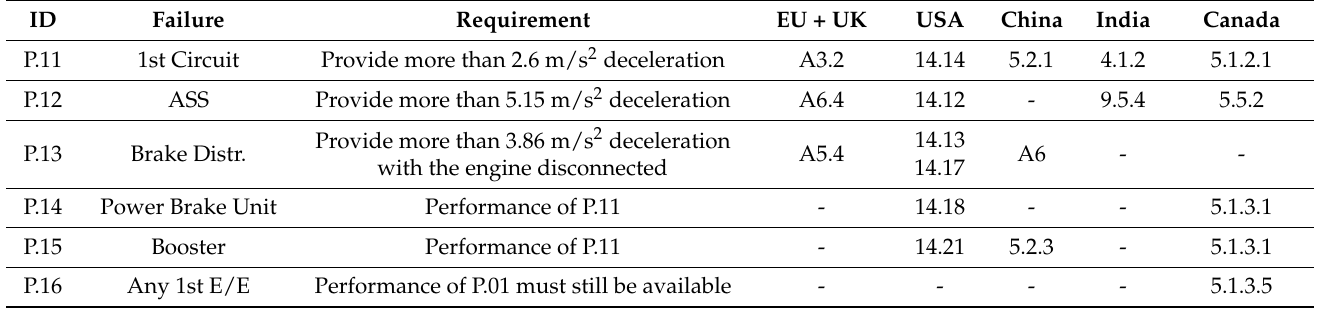
Table 3. Sections of the standard documents related to the performance requirements for degraded EMB service braking